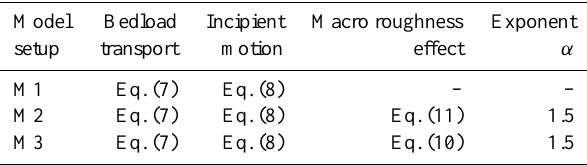
Table 1. Model setups of TOPKAPI and SETRAC used to simulate the 2005 event. M3 was only used for